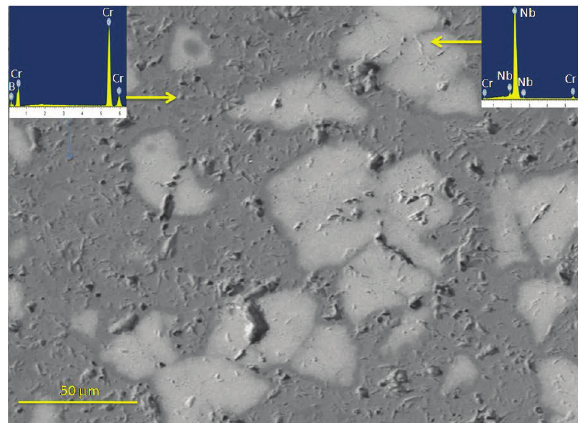
Figure 5 : SEM image and elemental analysis of different phases in CrB 2 composite prepared by addition of 20% Nb.